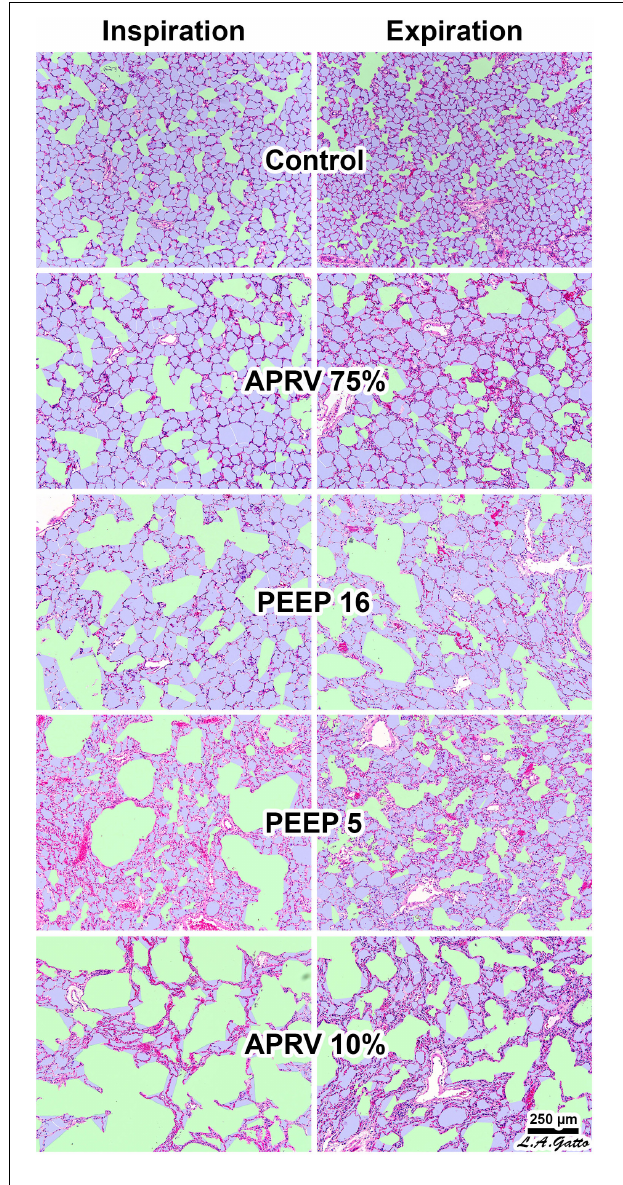
FIGURE 7 | Rat lungs fixed at inspiration and expiration in normal lungs ( Control ) and in a Tween lavage ARDS model with four ventilation strategies: (1) the TCAV method setting airway pressure release ventilation (APRV) with the expiratory flow termination (E FT ) at 75% of expiratory flow peak (E FP ) (E FT /E FP = 75%) ( APRV 75% ) (Habashi, 2005; Jain et al., 2016); (2) E FT /E FP = 10% ( APRV 10% ), which significantly increased expiratory time; (3) controlled mandatory ventilation (CMV) with low tidal volume (6 mL/kg) with 5 cm H 2 O positive end-expiratory pressure ( PEEP 5 ); or (4) CMV with low tidal volume (6 mL/kg) with 16 cm H 2 O PEEP ( PEEP 16 ). APRV 10% (not the TCAV method) significantly increased expiratory duration, allowing sufficient time for alveoli to collapse. The conducting airways are depicted in green; alveoli in lilac; and remaining interstitium, blood vessels, and lymphatics in magenta. The size of each microanatomical area was quantified using computer image analysis. In the Control group all alveoli were inflated surrounding normally distended alveolar ducts. Following Tween-induced ARDS, alveolar ducts in all ventilation groups were increased in size. In the CMV groups alveolar ducts were overdistended at both inspiration